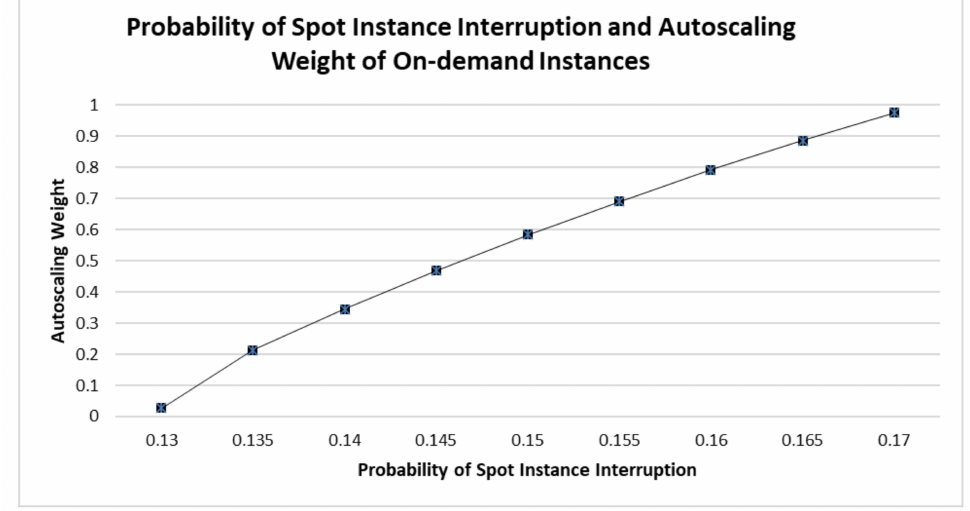
Figure 4. Probability of Spot Instance Interruption and Autoscaling Weight of On-demand